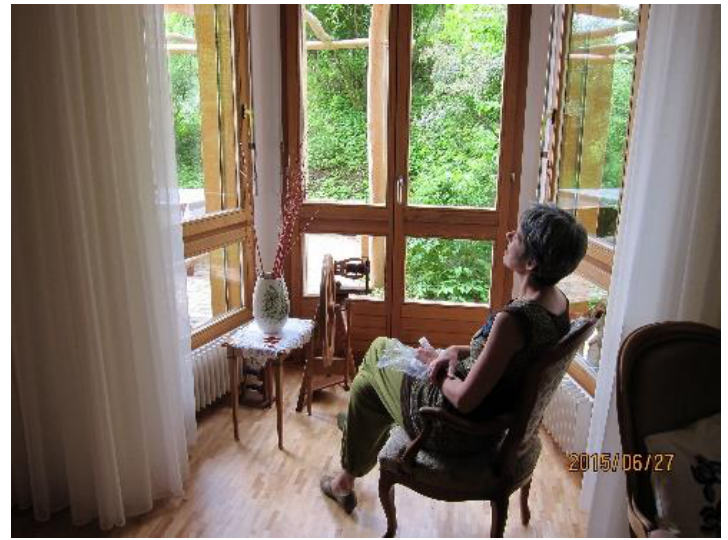
Figure 5: A place for quiet rest and meditation by the window of the day care attached to the senior citizens' residence (Walklingen, Switzerland June 2015, courtesy of the